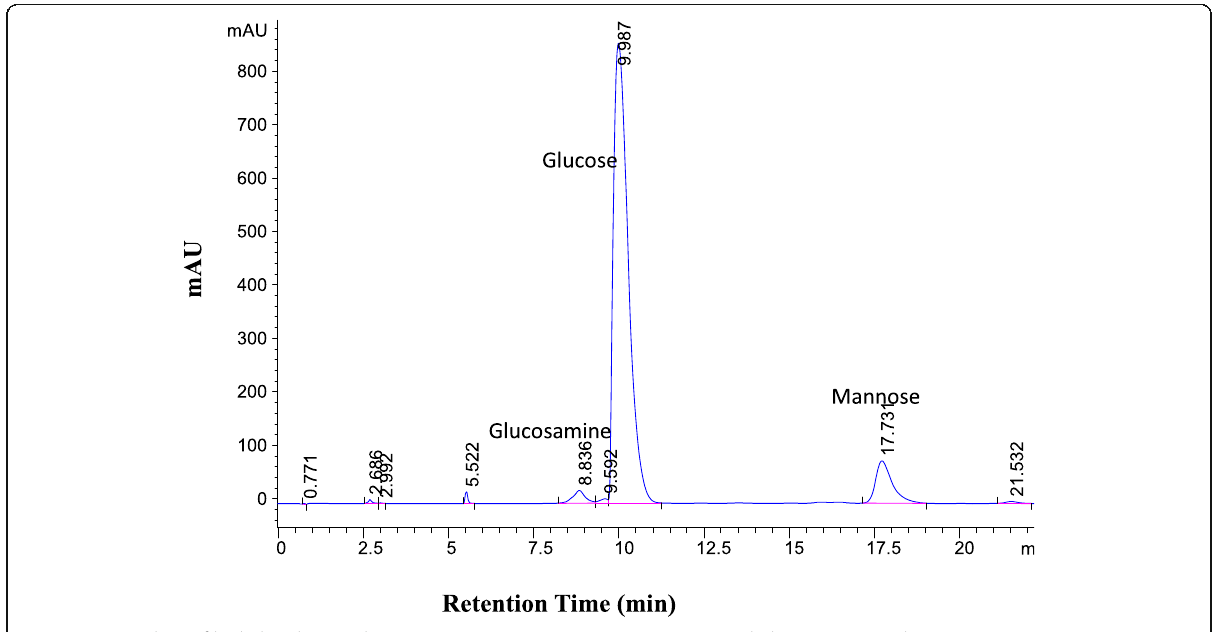
Fig. 5 HPLC analysis of hydrolyzed ECP. (Glucose is a major monomeric unit; mannose and glucosamine are the minor